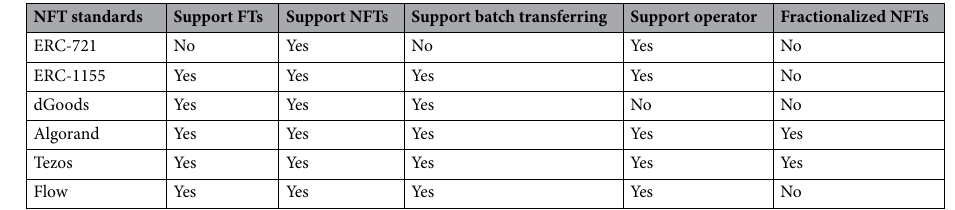
Table 1. Comparing NFT